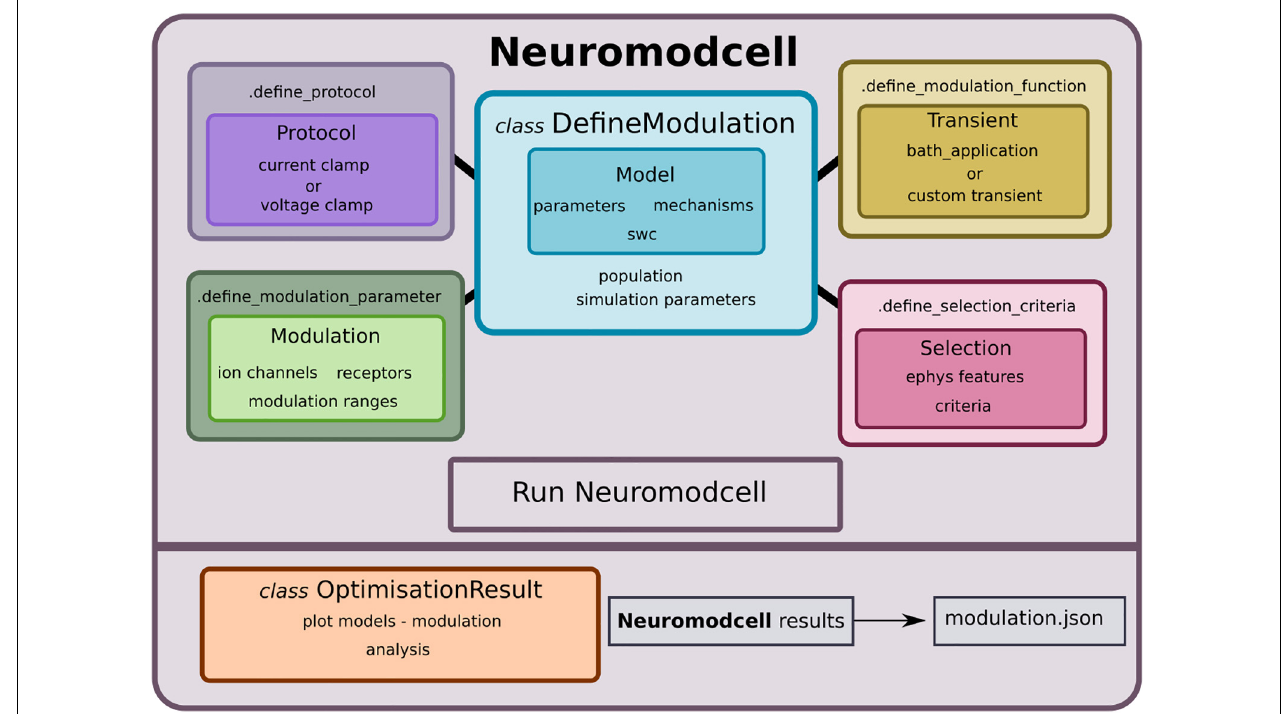
FIGURE 1 | Neuromodcell structure with classes and methods. Neuromodcell specifies the model and optimization parameters using the DefineModulation class. The associated methods define the protocols, parameters, modulation, and selection criteria for the optimization. Following the simulation, the OptimisationResult class assists in loading and analyzing the results and saving the final modulation (modulation.json).